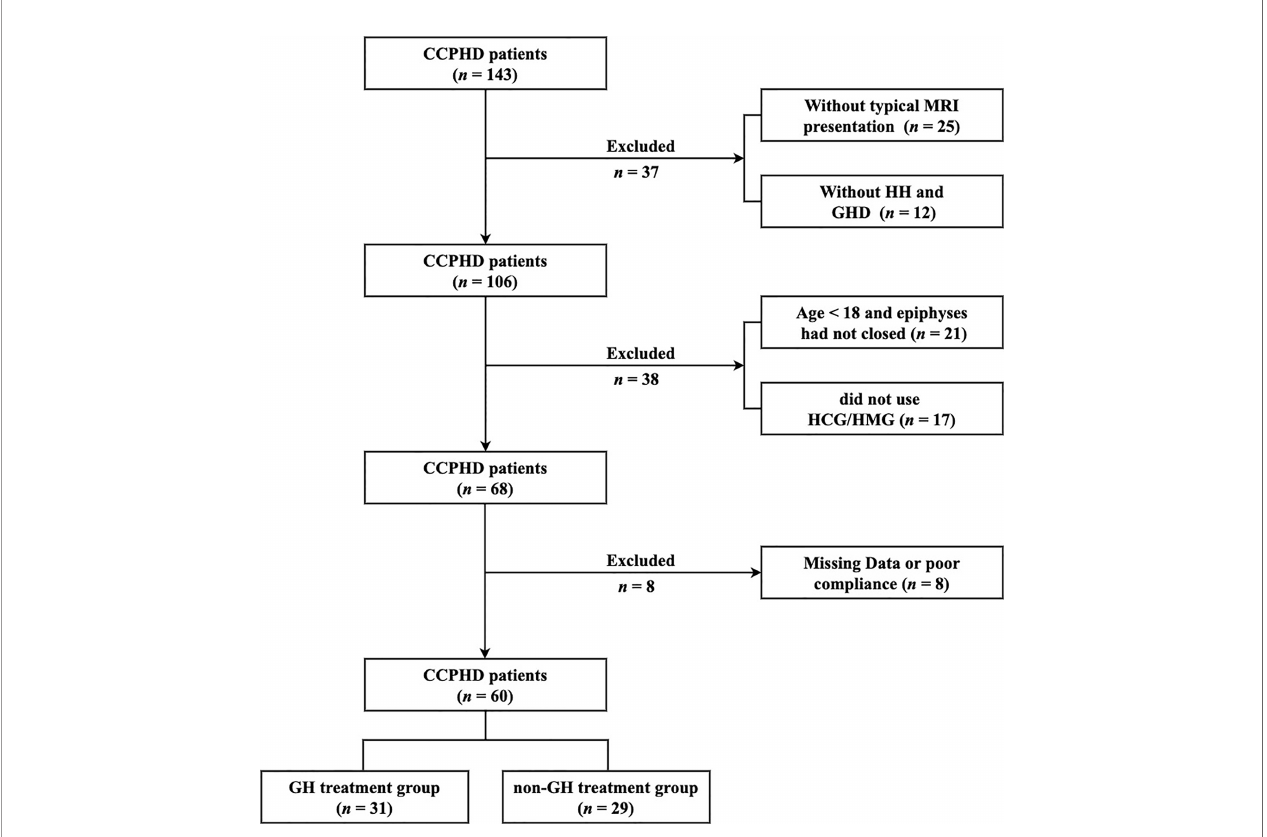
FIGURE 1 | The fl owchart of patient screening. CCPHD, Congenital combined pituitary hormone de fi ciency; MRI, Magnetic resonance imaging; HH, Hypogonadotropic hypogonadism; GHD, Growth hormone de fi ciency; HCG, Human chorionic gonadotrophin; HMG, Human menopausal